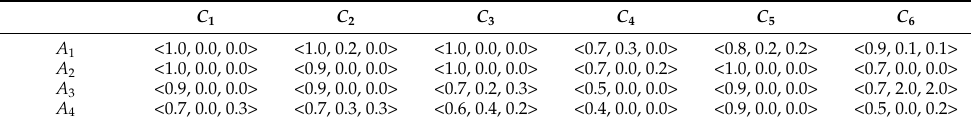
Table 1. The ratings of three tablets obtained from the first of three IT specialist.